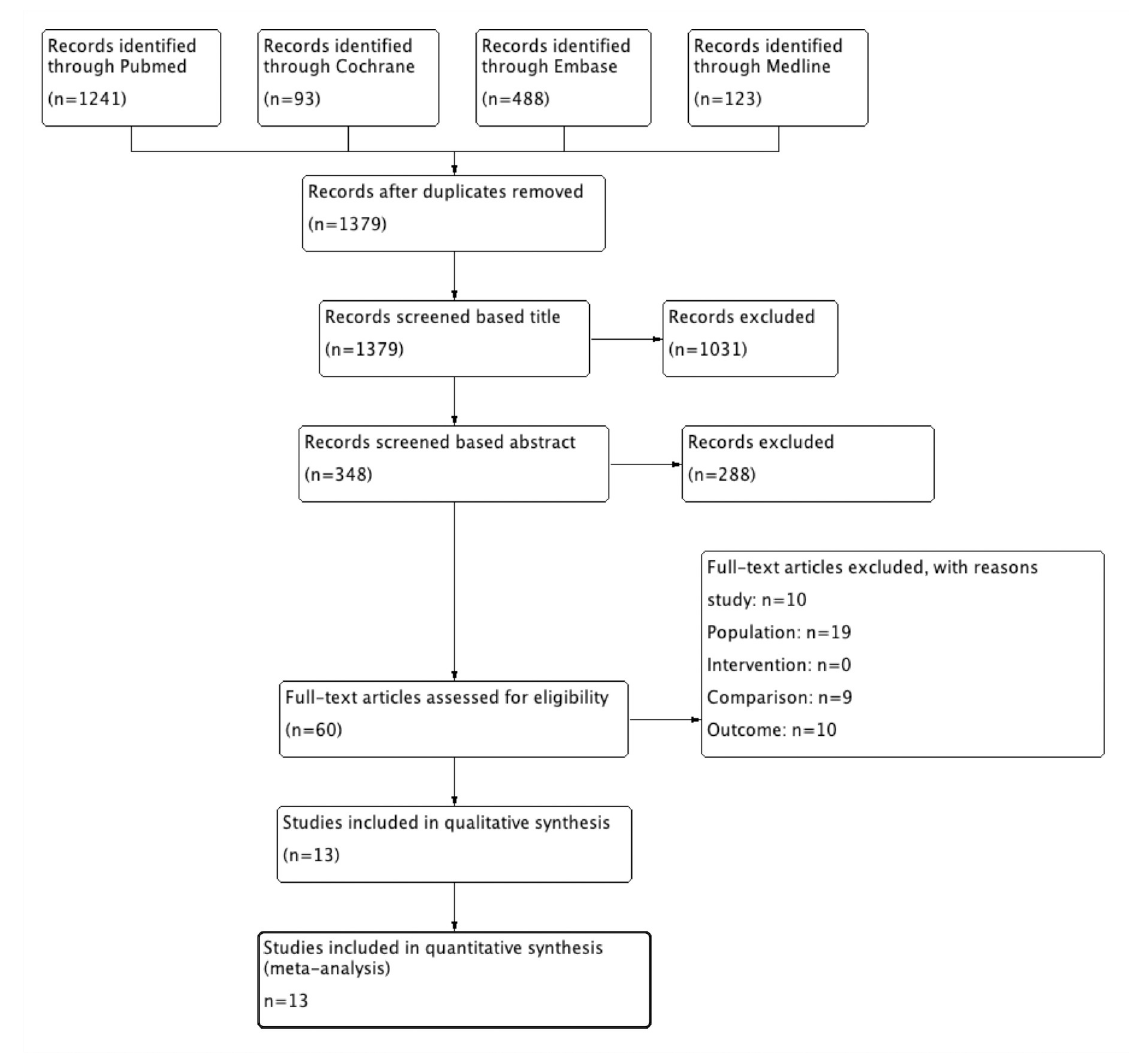
Fig 1. Flow diagram of selecting